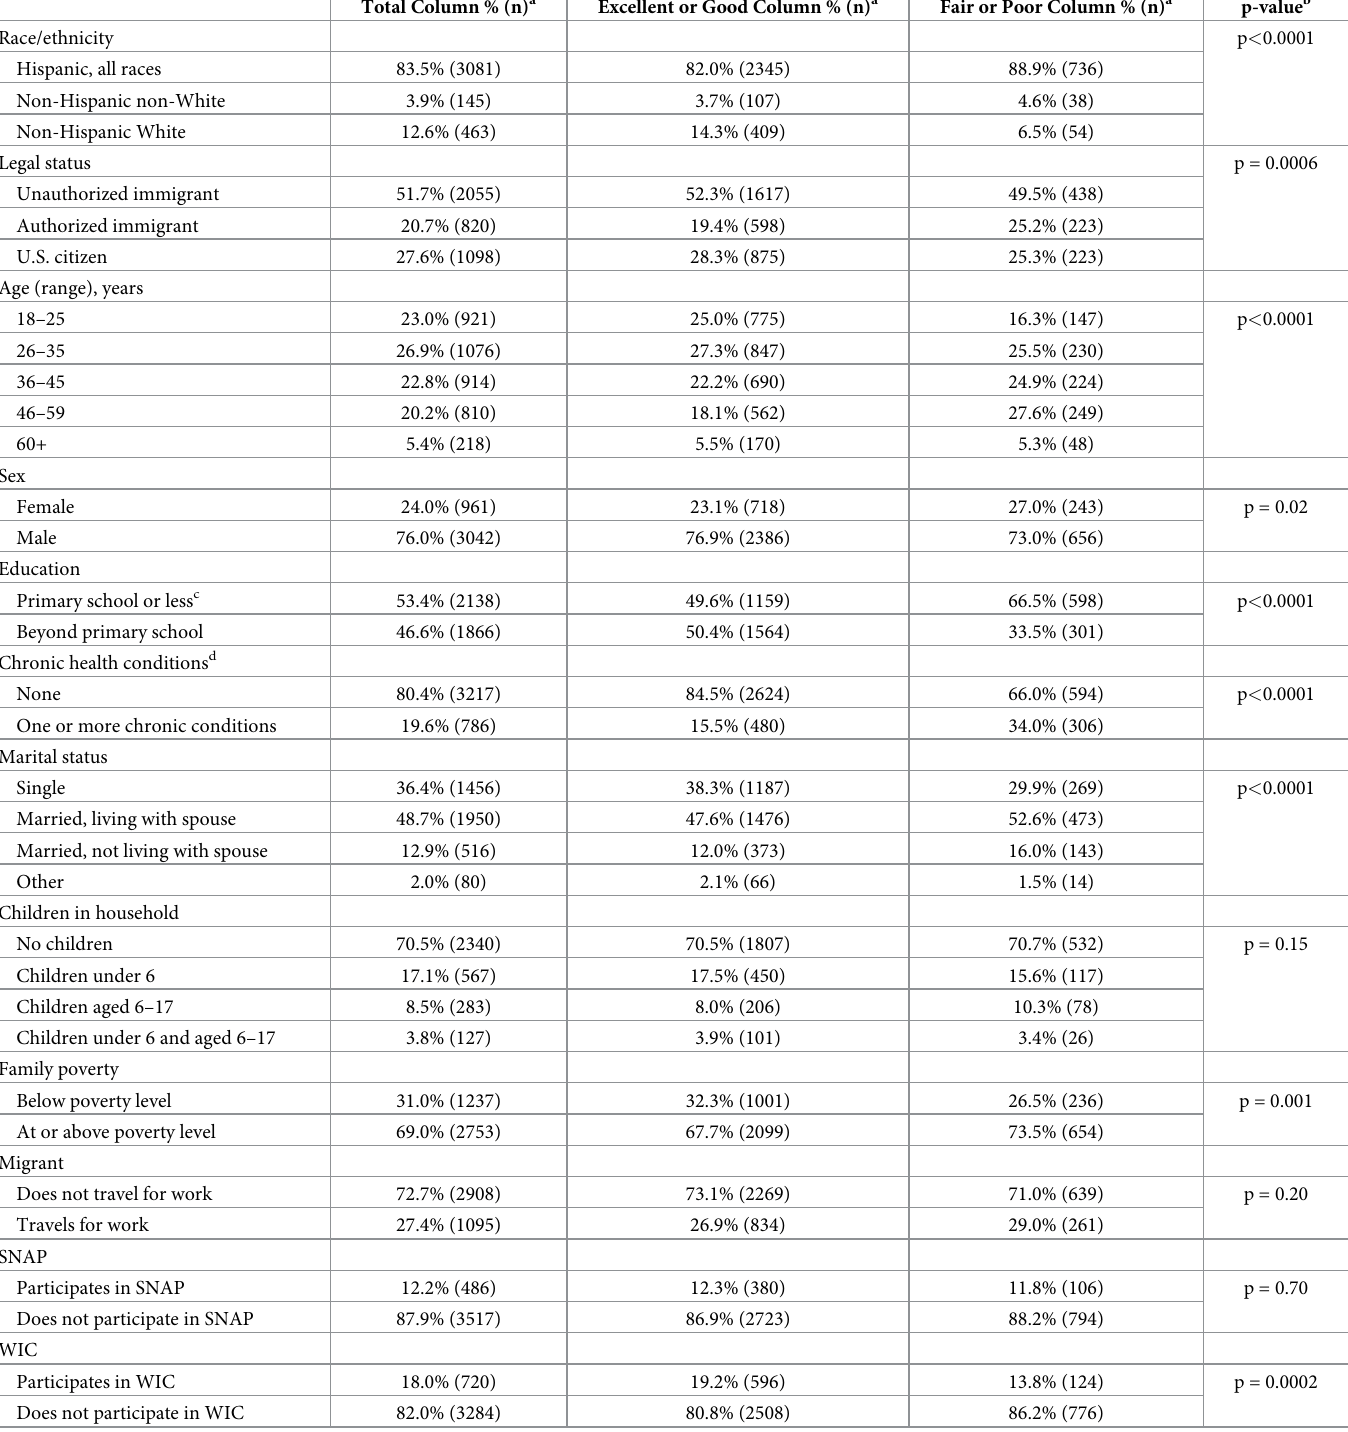
Table 1. Characteristics of U.S. farmworkers by self-reported health status: National Agricultural Workers Survey, 2009/2010 (n =